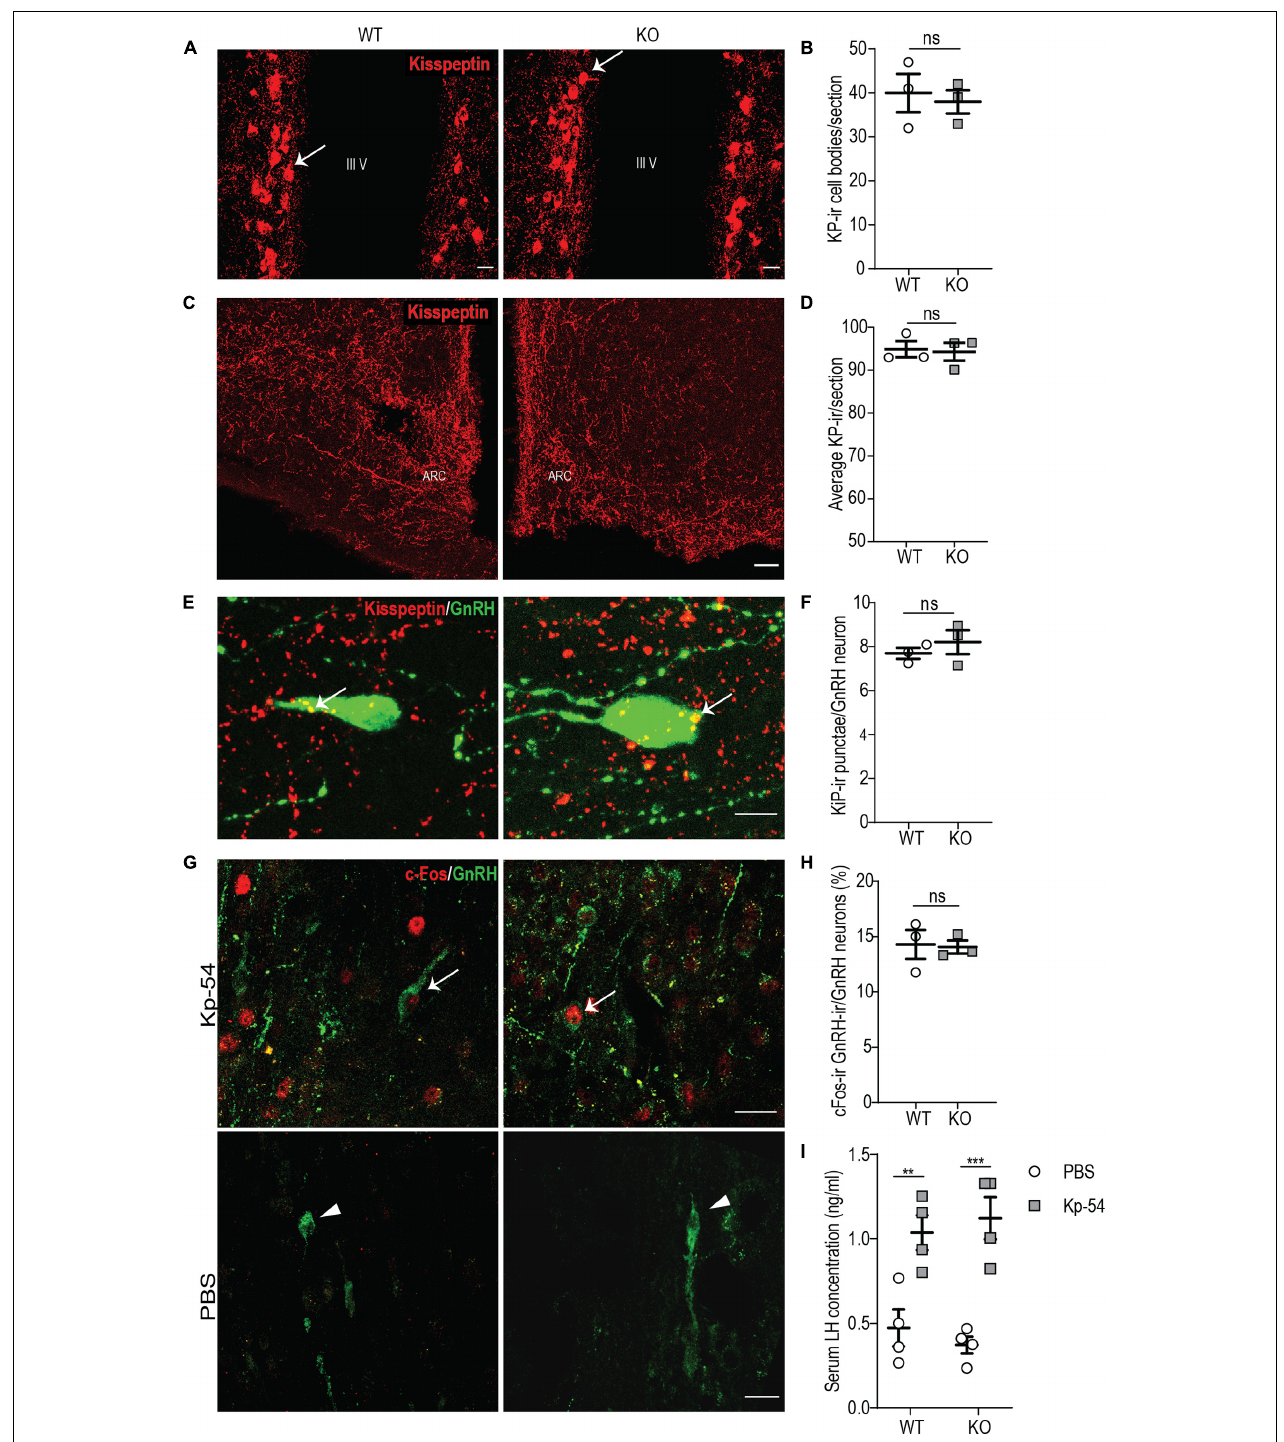
FIGURE 6 | p140Cap KO females show a normal KP neuroanatomy and a normal GnRH/LH response to exogenous KP. (A) Maximum intensity projections of z-stack images (5 serial image planes; z step size = 2 µ m) of KP neurons in the RP3V region of the hypothalamus of P60 p140Cap KO and WT female mice. Arrows indicate KP neurons; III V, 3 rd ventricle. Scale bar: 10 µ m. (B) Number of KP neurons in the RP3V of p140Cap KO and WT P60 female mice. n = 3 WT mice; 3 p140Cap KO mice; at least 4 sections were analyzed for each mouse. Unpaired, two-tailed t -test, P = 0.71. (C) Maximum intensity projections of z-stack images (10 serial image planes; z step size = 1 µ m) of KP fibers in the arcuate nucleus of P60 p140Cap KO and WT mice. ARC, arcuate nucleus of the hypothalamus. Scale bar: 50 µ m. (D) Average KP immunoreactivity (-ir) in the arcuate nucleus of P60 p140Cap KO and WT mice. n = 3 WT mice; 3 p140Cap KO mice; at least 5